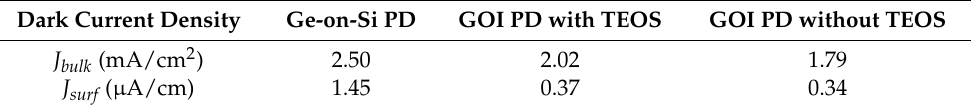
Figure 4. Dark current density ( J total ) versus 1/D of PDs at − 1 V reverse bias. Table 1. Dark current density comparison of PDs on three types of substrates.